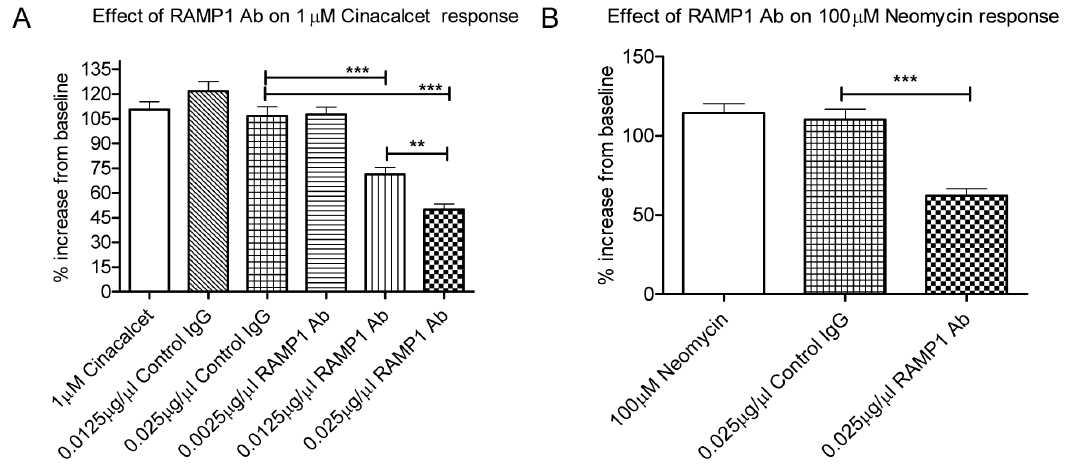
Figure 6. Attenuation of CaSR response in TT cells by RAMP1 antibodies. (A) Concentration-dependant decrease in Cinacalcet-induced intracellular calcium release in presence of 1.5 mM CaCl 2 , by RAMP1 antibodies in TT cells. Total cells analysed combined from five independent experiments are 272 (1 m M Cinacalcet), 261 (0.0125 m g/ m l control IgG), 240 (0.025 m g/ m l control IgG), 252 (0.0025 m g/ m l RAMP1 Ab), 272 (0.0125 m g/ m l RAMP1 Ab) and 250 (0.025 m g/ m l RAMP1 Ab). (B) 0.025 m g/ m l RAMP1 antibody caused a significant inhibition of 100 m M Neomycin response in presence of 2 mM CaCl 2 compared to control IgG. Total cells analysed combined from five independent experiments are 192 (100 m M Neomycin), 177 (0.025 m g/ m l control IgG) and 166 (0.025 m g/ m l RAMP1 Ab). *** p , 0.001 determined by Kruskal-Wallis test, Dunn’s multiple comparison post-test, ** p , 0.01 two- tailed Mann-Whitney test.